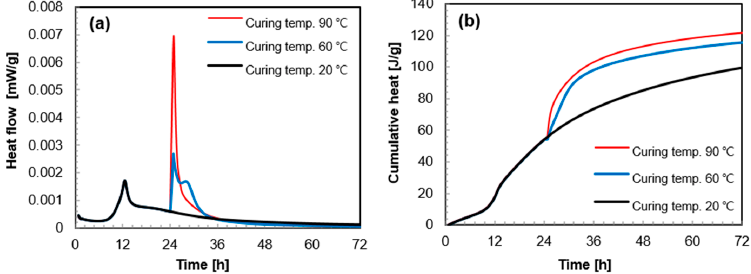
Figure 3. Heat flow ( a ) and cumulative heat ( b ) of UHPC cured under 20 °C, 60 °C, and 90 °C (the elevated temperature curing at 60 °C or 90 °C started from 24 h).